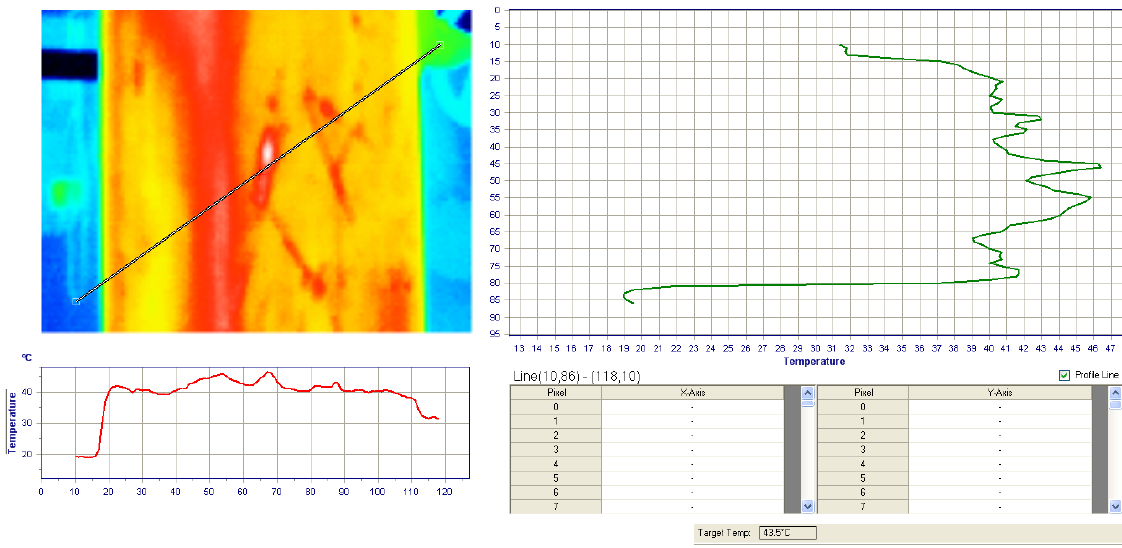
Figure 10. HEx1 geothermal water outlet pipe.